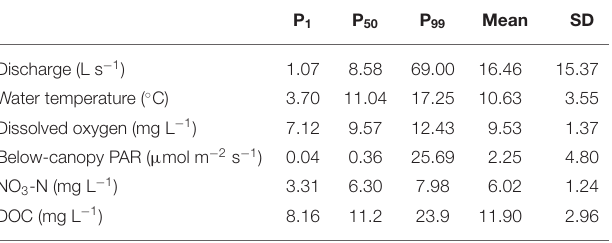
TABLE 2 | Summary statistics for nutrients and their explanatory variables across the entire monitoring period.